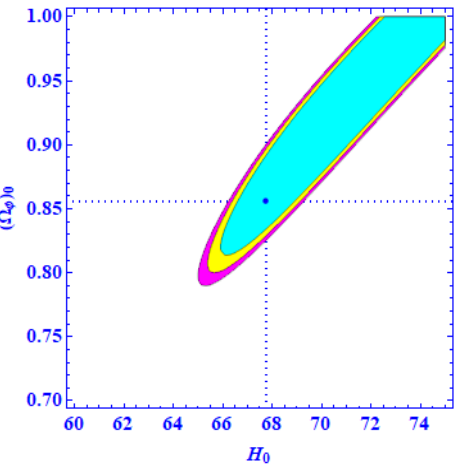
Figure 6. Two-dimensional contours in the ( H 0 − ( Ω φ ) 0 plane at 1 σ , 2 σ and 3 σ confidence regions by bounding our model with joint H ( z ) and BAO